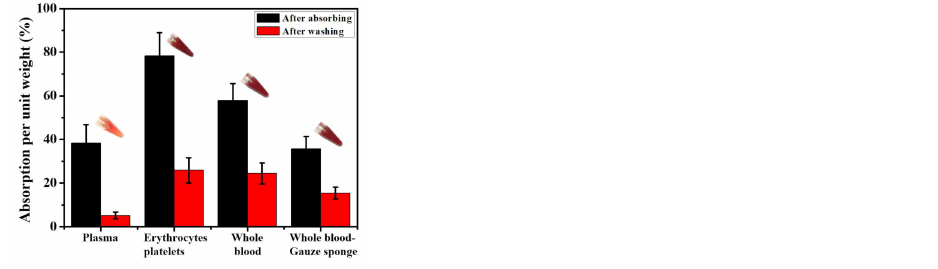
Figure 3. In vitrobloodabsorptiontestoftheChi-GOsponges. Datavaluescorrespondedtomean ± SD, n =